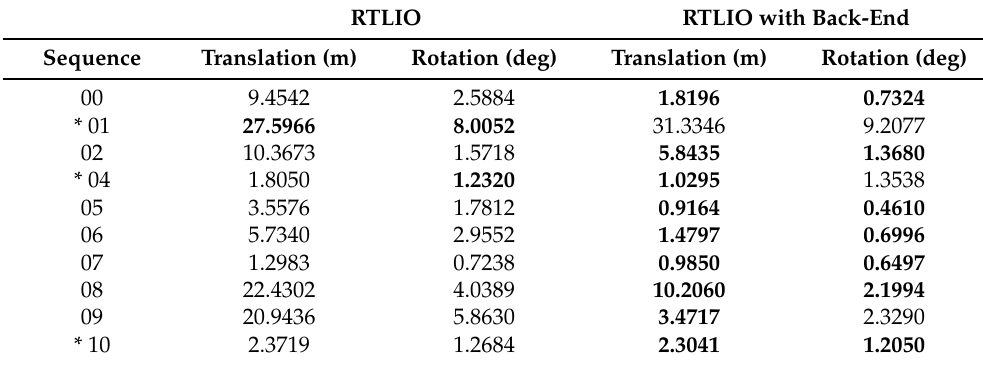
Table 3. Translation and rotation of APE in the KITTI